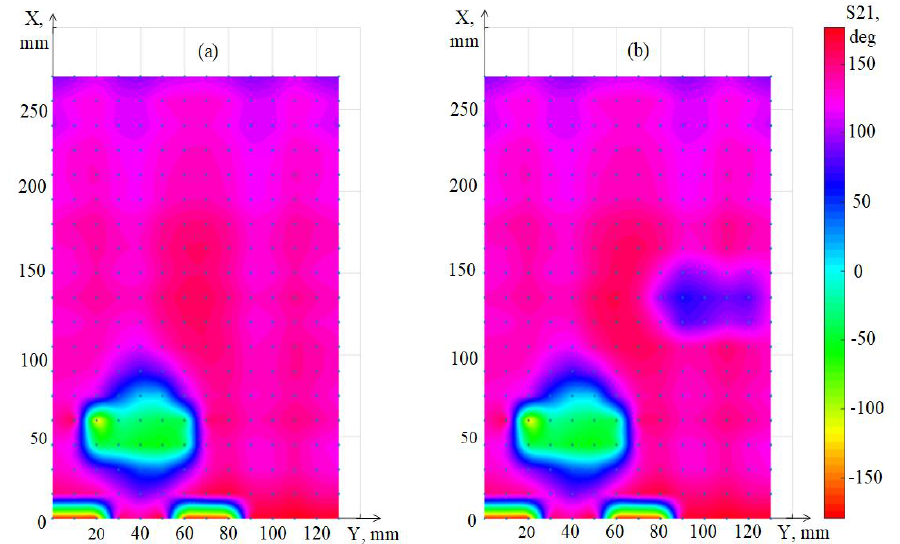
Fig. 5. Simulation results of the phase of the transmission coefficient estimation with a 1200 MHz signal without heterogeneity (a) and with heterogeneity